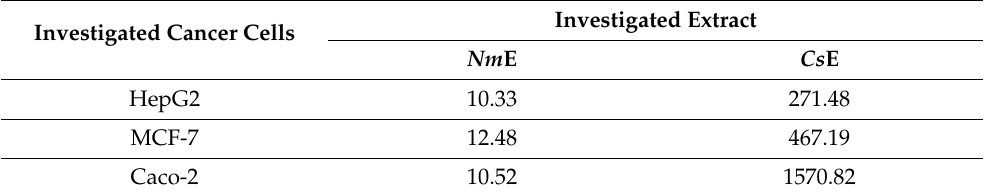
Table 2. The IC 50 values ( µ g/mL) for Nm E and Cs E on HepG2 cells.